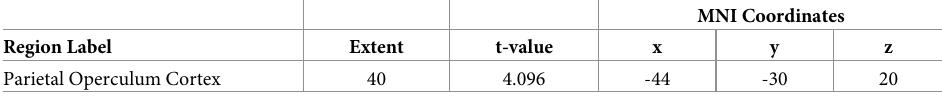
Table 1. The activated region that exhibited a significant negative correlation with age (p < .05